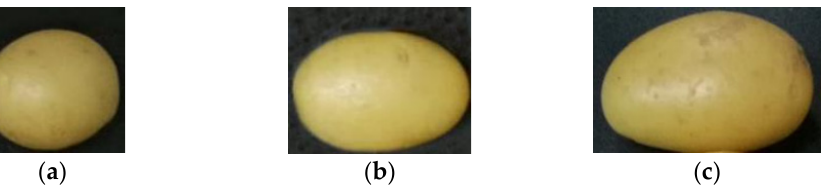
Figure 3. Classification of mini-tuber seeds: ( a ) class of spherical; ( b ) small ellipsoid; ( c ) large ellip- soid. Reprinted with permission from ref. [30]. Copyright 2018 China Agricultural University.